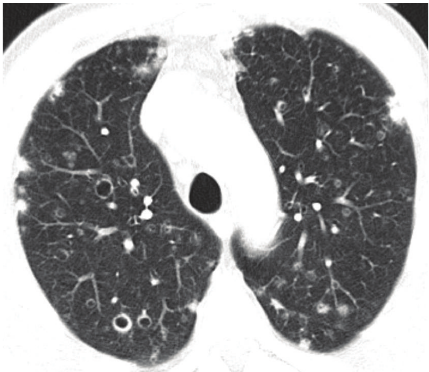
Figure 2: Axial thoracic CT (lung window): multiple bilateral pulmonary nodules are identified in different stages of cavitation, a typical finding of pulmonary LCH.